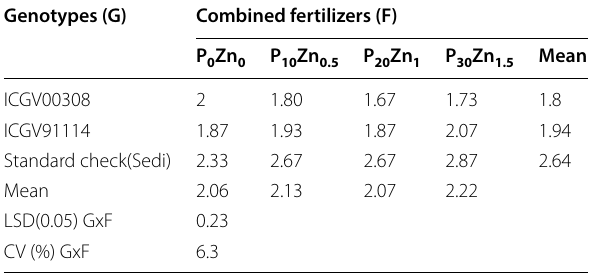
Table 5 The interaction effect of genotypes and PZn fertilizer on number of seeds/pod